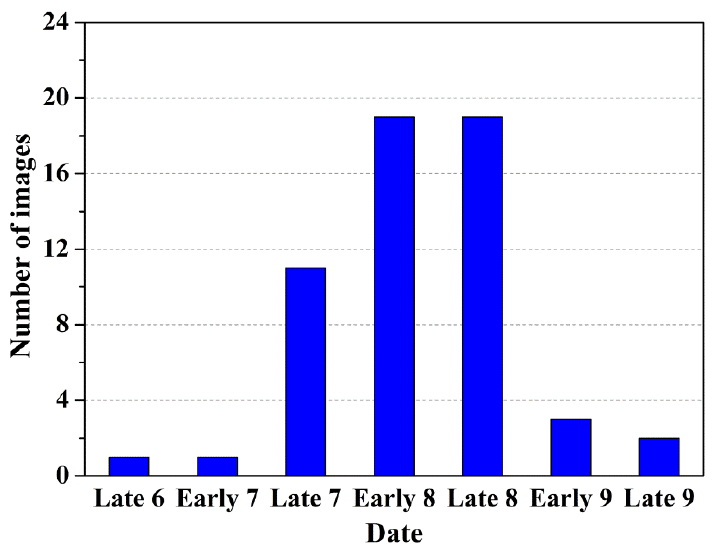
Figure 4. The time distribution of the selected Landsat images to derive SLA.